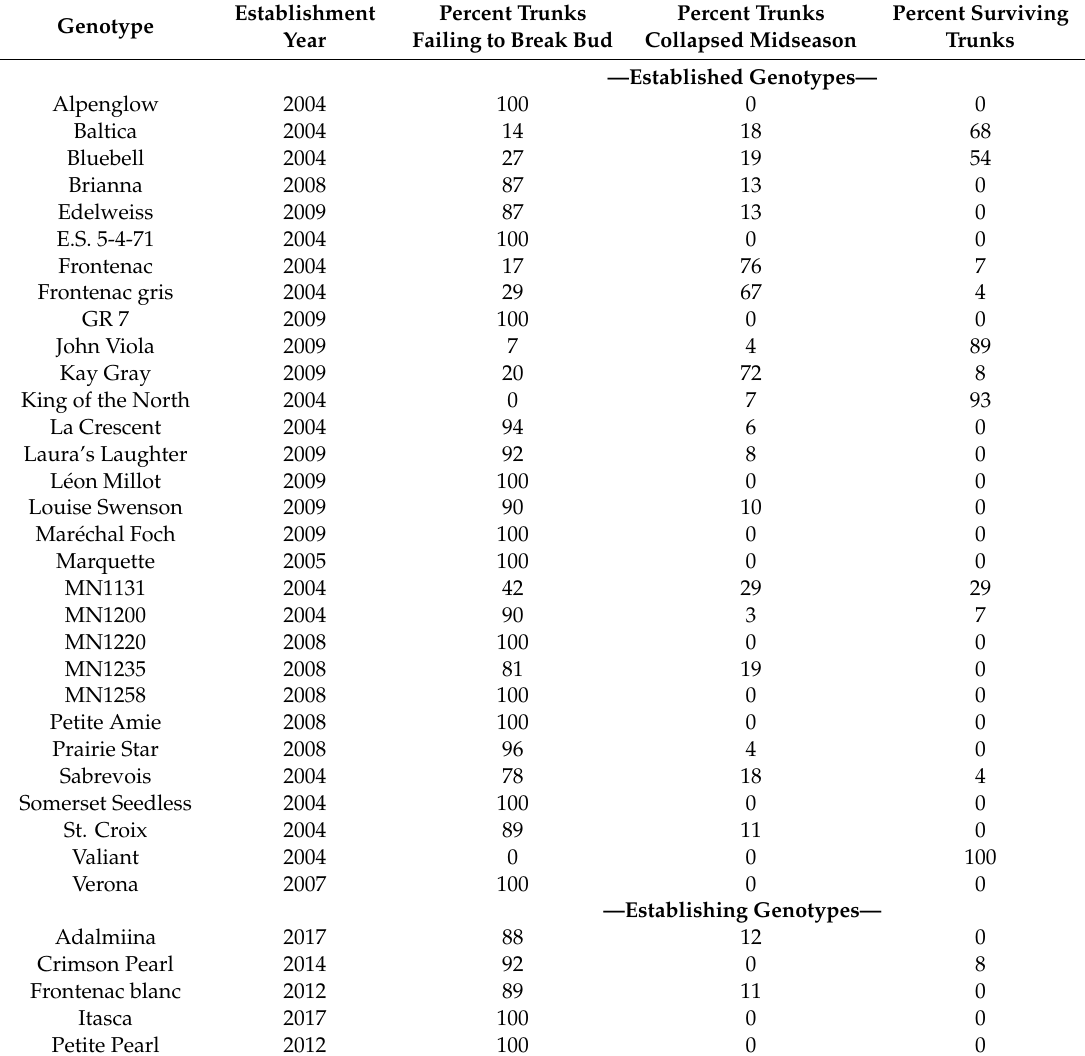
Table 1. Trunk survival evaluations for cold-hardy grapevine genotypes at the NDSU Horticulture Research Farm near Absaraka, ND, USA following the 2018–2019